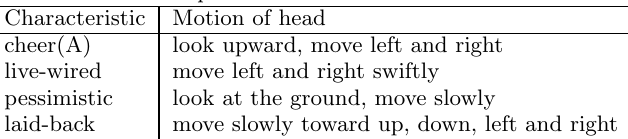
Figure 1: System views of birth and inheritance between parents and child robot